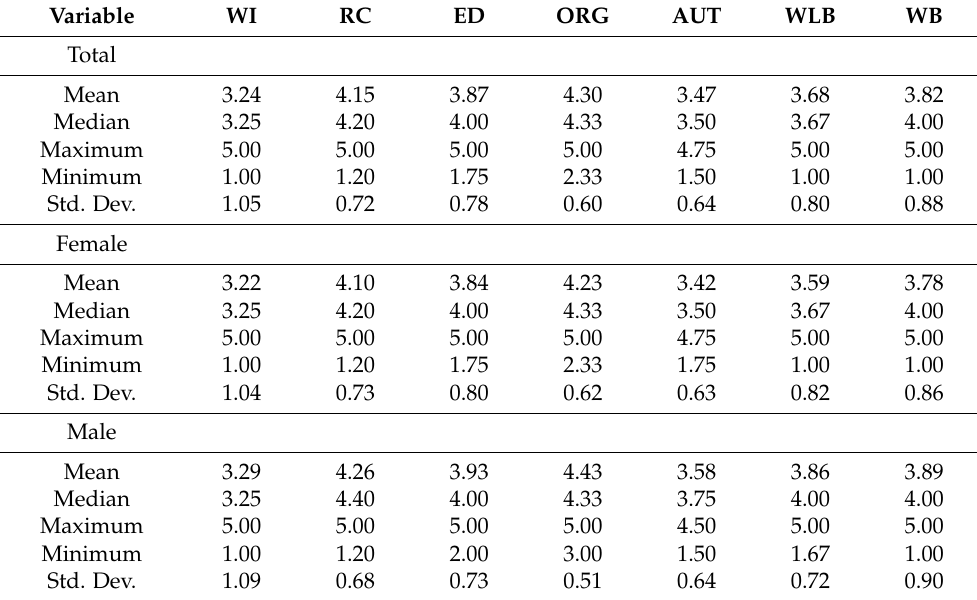
Table 2. Descriptive statistics of variables.